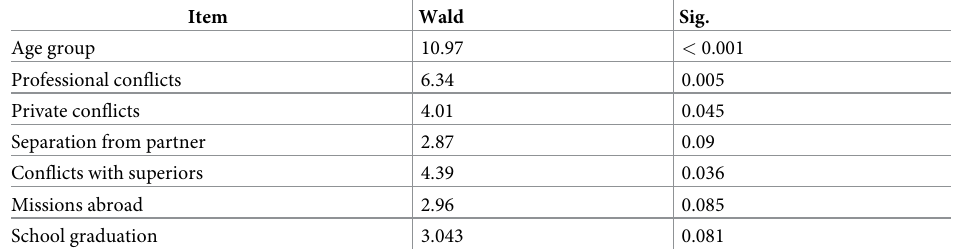
Table 6. Likelihood-ratio-regression analysis to distinguish between attempted and completed suicides. Item Wald Sig. Age group 10.97 <